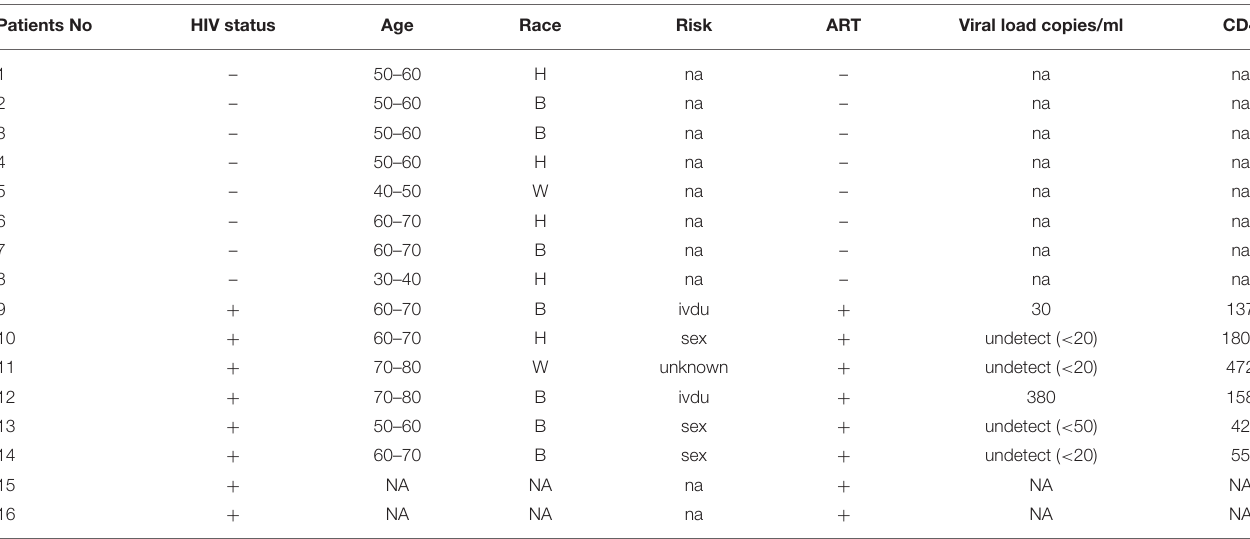
TABLE 3 | Patient’s